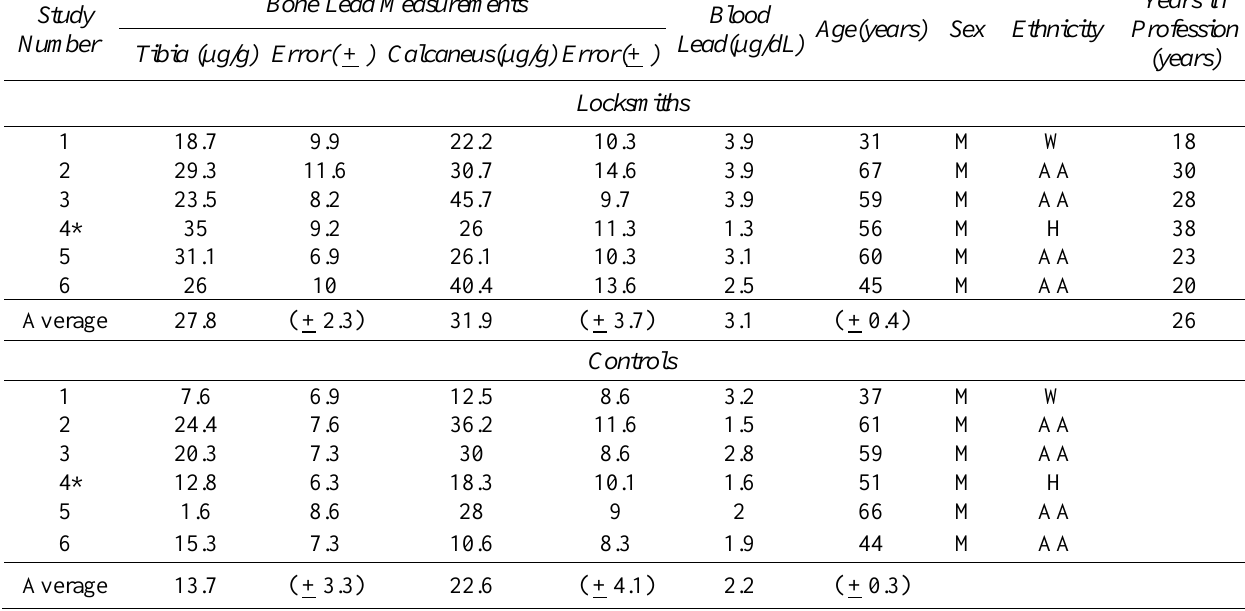
Table 1: Bone and Blood Lead Measurement for Locksmiths and Case Matched Controls Charles R. Drew University of Medicine and Sciences, Los Angeles, California, December 2003 to January 2004. Bone Lead Measurements